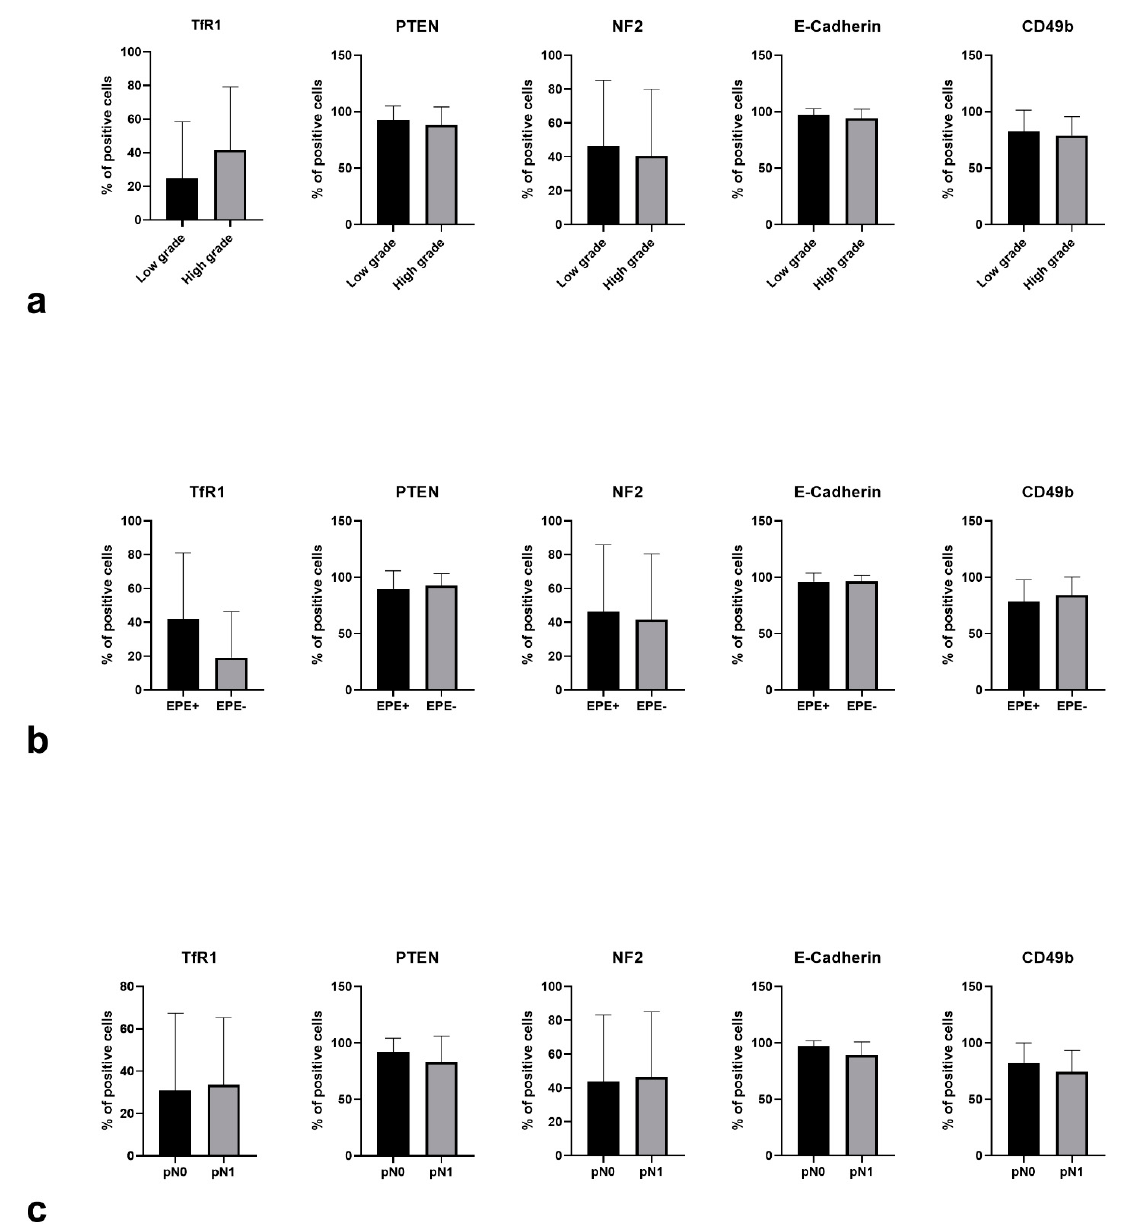
Figure 1. Examples of TFR, e-cadherin, and CD49 immunoreactivity in PCa. ( a ) High-grade PCa with positive TFR expres- sion (marked with asterix); benign prostate glands are visible on the left and serve as internal negative control. ( b ) Low- grade PCa with negative TFR expression; TFR-positive nerve bundles are visible in the center and serve as internal positive control (marked with arrows, cancer cells marked with asterix). ( c ) PCa with NI and reduced e-cadherin expression in high-grade cancer glands on the left (marked with asterix) and normal expression in low-grade cancer glands on the right. ( d ) PCa with no NI and normal e-cadherin expression (marked with asterix). ( e ) PCa with reduced CD49 expression (marked with asterix); benign prostate glands are visible on the left and serve as internal positive control. ( f ) PCa with normal CD49 expression (marked with asterix). ( g ) PCa with EPE and positive TFR expression (marked with asterix); benign prostate glands are visible on the right and serve as internal negative control. ( h ) PCa confined to prostate and negative TFR. ( i ) PCa with EPE and reduced e-cadherin expression in cancer glands on the right (marked with asterix) and normal expression in benign glands on the left. ( j ) PCa confined to prostate with normal e-cadherin expression (marked with asterix). Original magnification in photomicrograph ( a ): 40×, in photomicrographs ( b – j ): 100×.